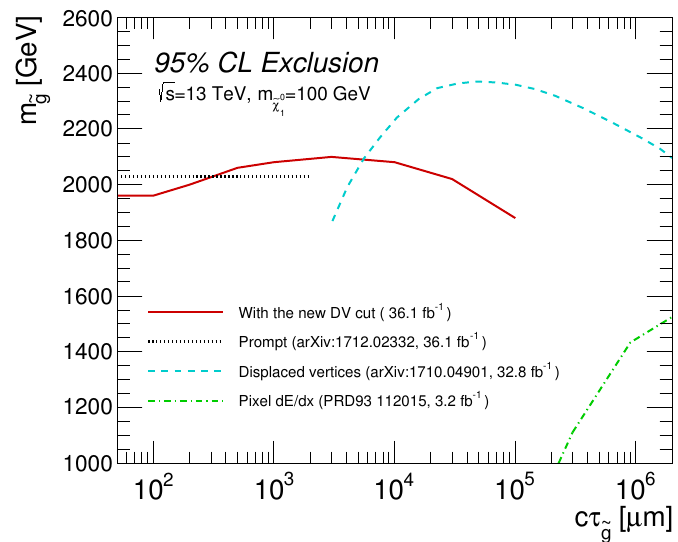
Figure 9. The 95% CL expected exclusion limit on the gluino mass with L = 36 : 1 fb (cid:0) 1 at the 13 TeV LHC run as a function of c(cid:28) ~ g (red solid line). For comparison, we also show the 95% CL exclusion limits given by the ATLAS prompt-decay gluino search (black dotted line) [144], the ATLAS displaced-vertex search (blue dashed line) [67], and the ATLAS search of large ionization energy loss in the Pixel detector (green dot-dashed line)